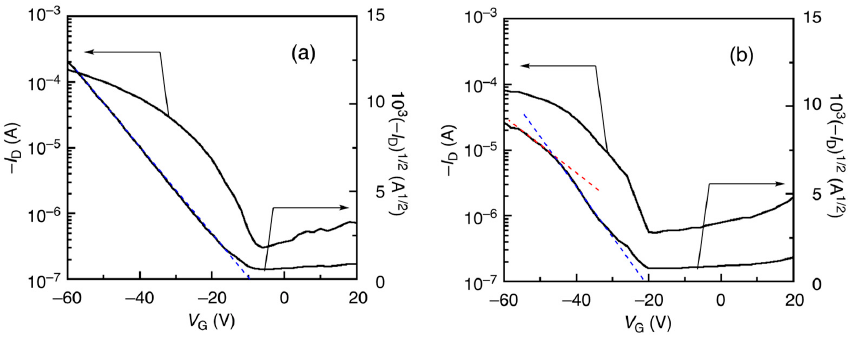
Figure 3. Charge transfer characteristics of the OFETs using poly( 1 - alt - 2 ) of entries 1 ( a ) and 5 ( b ) in Table 3 ( V D = − 60 V).